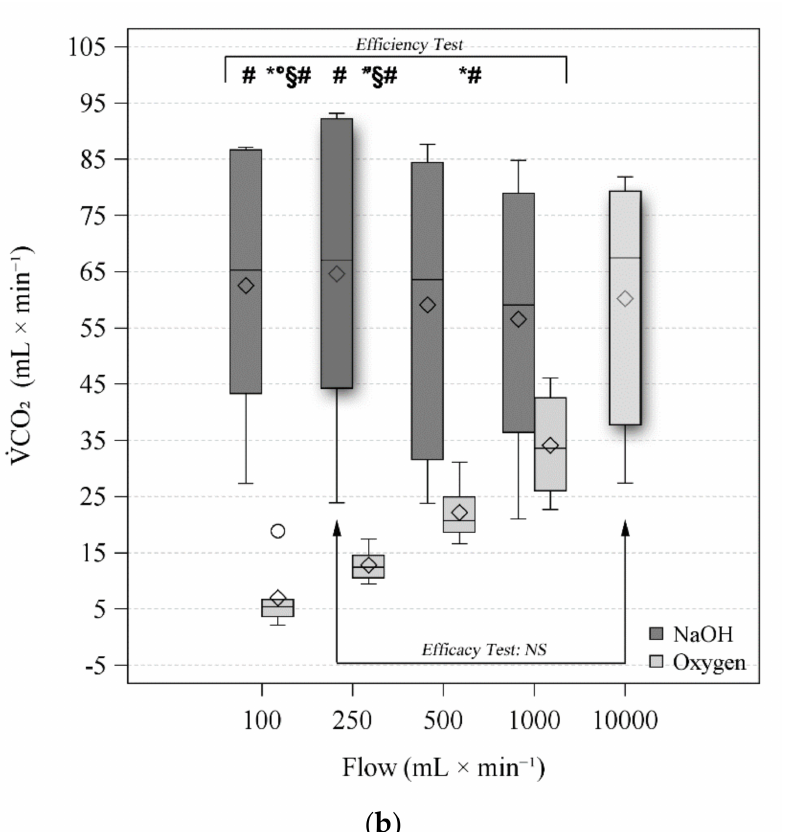
Figure 4. Figures display the distribution of data by using a rectangular box plot and whiskers, the bottom and top edges of the box indicate the intra-quartile range (IQR) between the first and third quartiles (the 25th and 75th percentiles). The diamond marker inside the box indicates the mean value. The line inside the box indicates the median value. Whiskers indicate the range of values outside of the intra-quartile range but at a distance lower than the upper and lower fences ( ± 1.5 × IQR) Dots represent outliers (observations that are more extreme than the upper and lower fences). Dark grey represents NaOH at 100 mmol × L − 1 concentration. Light grey represents Oxygen. Efficiency test statistical analysis: Two-way ANOVA RM. * p < 0.05 vs. NaOH; ◦ p < 0.05 vs. 250 mL × min − 1